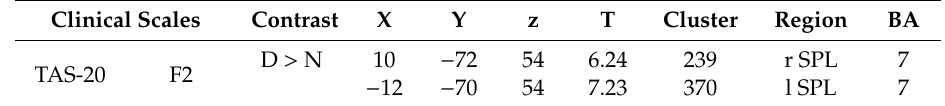
Table 2. Brain regions whose activity was negatively correlated to TAS-20 scores in mothers when contrasting infant emotional faces to infant neutral faces. Clinical Scales